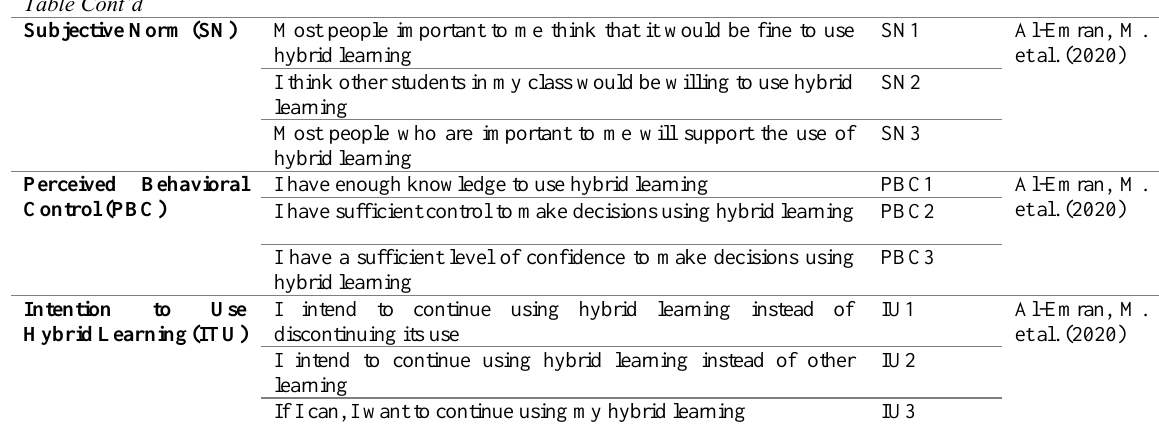
Table Cont’d Subjective Norm